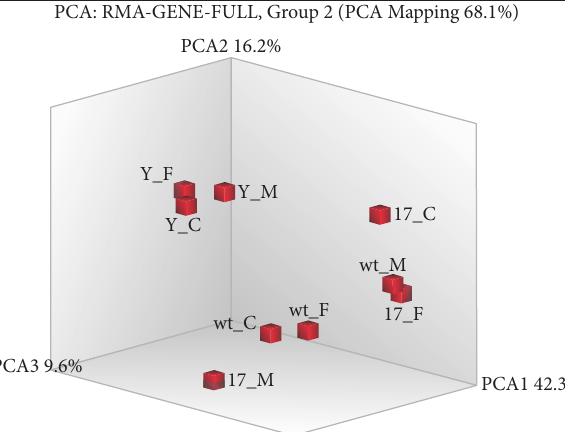
Figure 1: Principal Component Analysis (PCA) of UT-MSC, MSC- 𝛾 , and MSC-17. This 3-dimensional PCA graph identifies a new set of variables (PCA1, PCA2, and PCA3) that account for majority of the variability among the samples. PCA1 captures as much variability in the data as possible, PCA2 captures as much variability of the remaining variability not accounted by PCA1, and PCA3 captures as much of the remaining variability not accounted by PCA2. The symbols indicate IL-17A treated MSC, 17 ; IFN- 𝛾 treated MSC (Y ); and untreated-MSC (wt ). The 3 different MSC donors are indicated by C, M, and